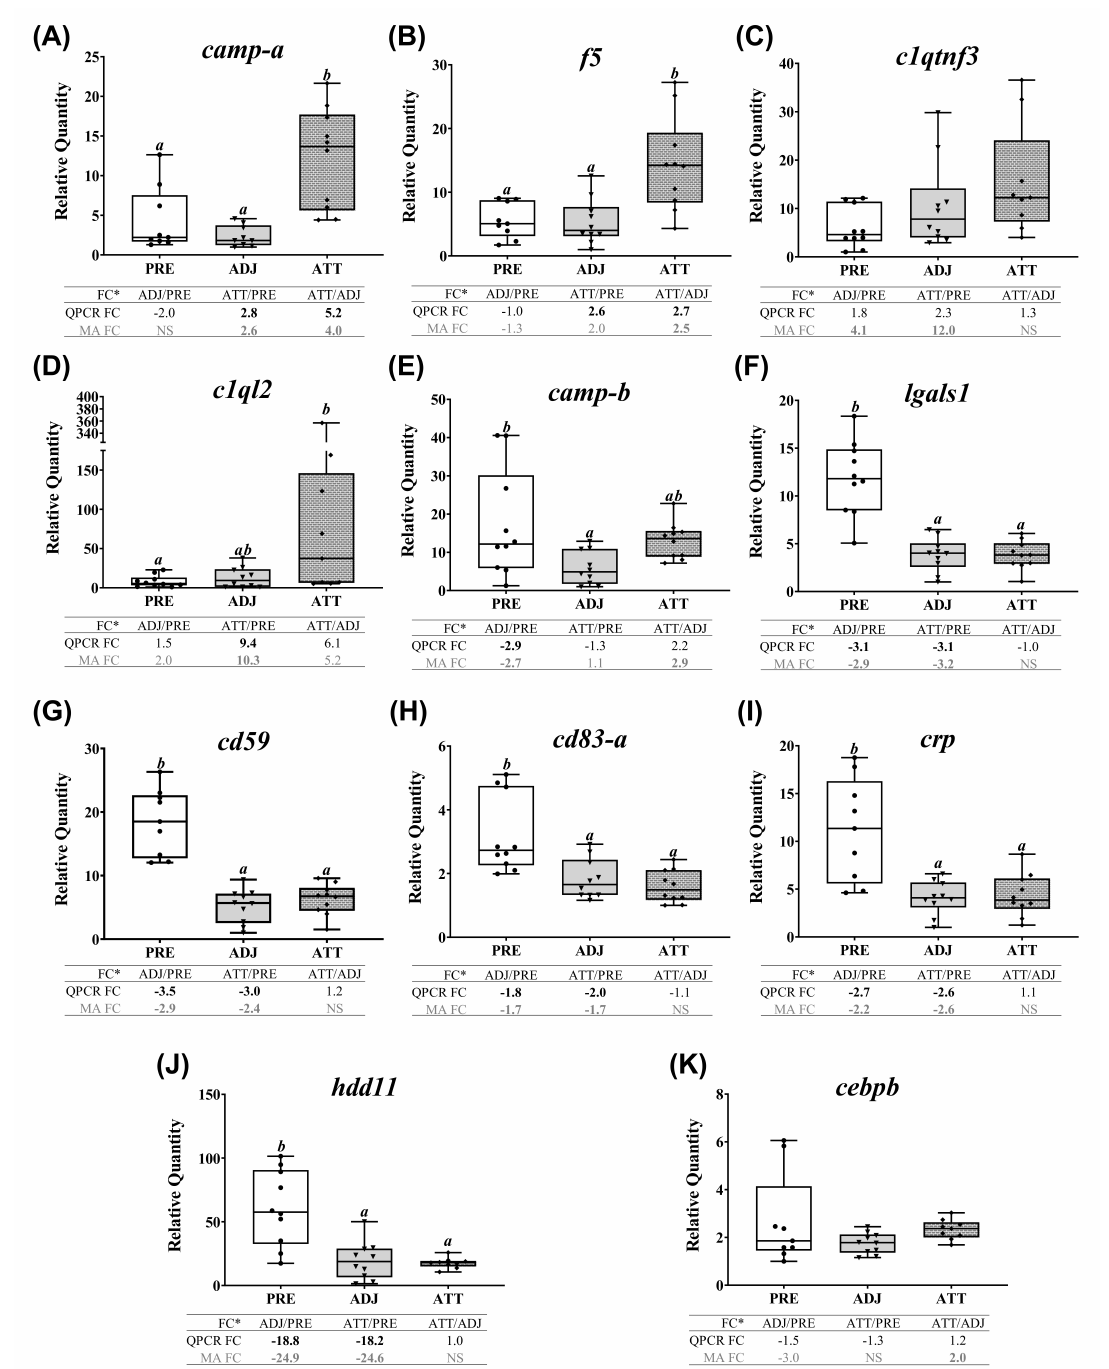
Figure 8. QPCR confirmation of selected microarray-identified transcripts in theme 2 (Tables 2 and 3) that are primarily associated with immunity and defense (not including antiviral response). For details of the captions, refer to Figure